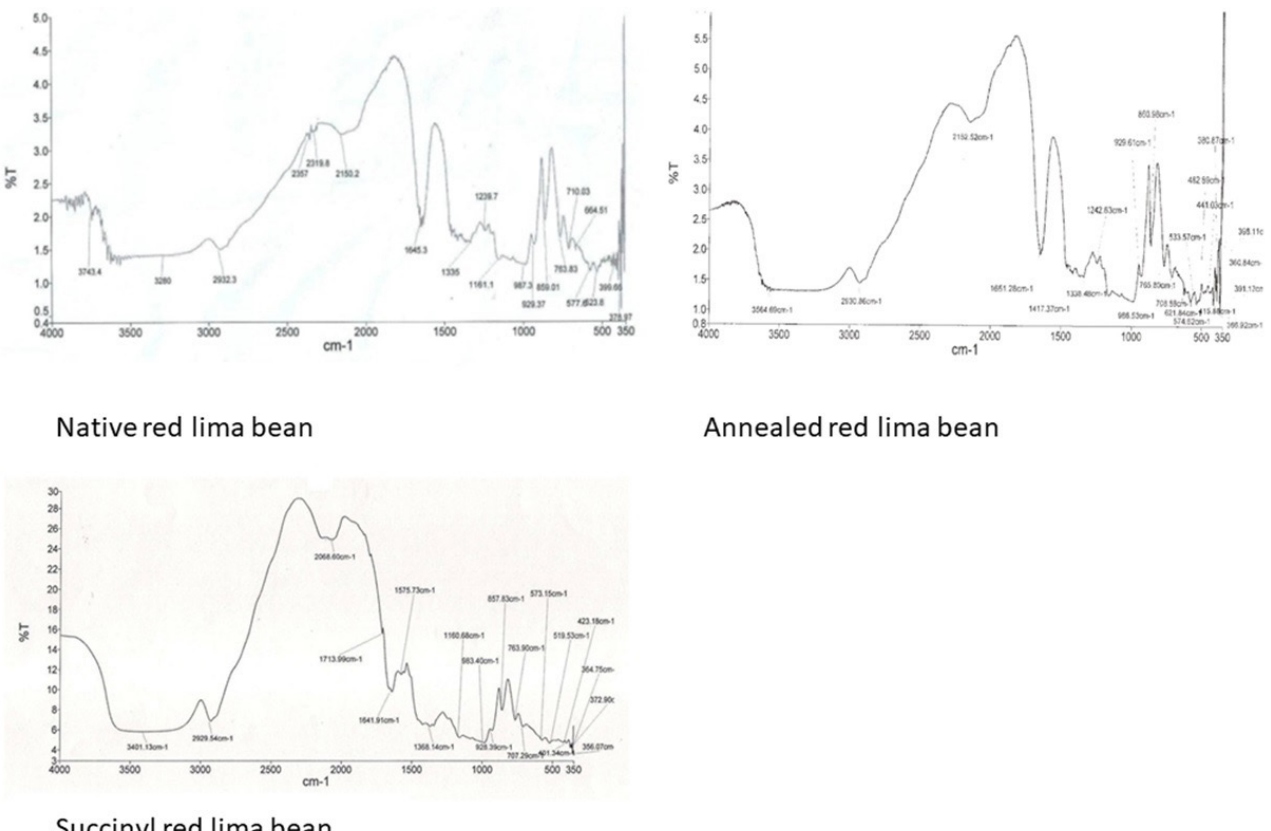
FIGURE 2 - FTIR Spectra of Succinyl, Annealed, and Native Lima Bean